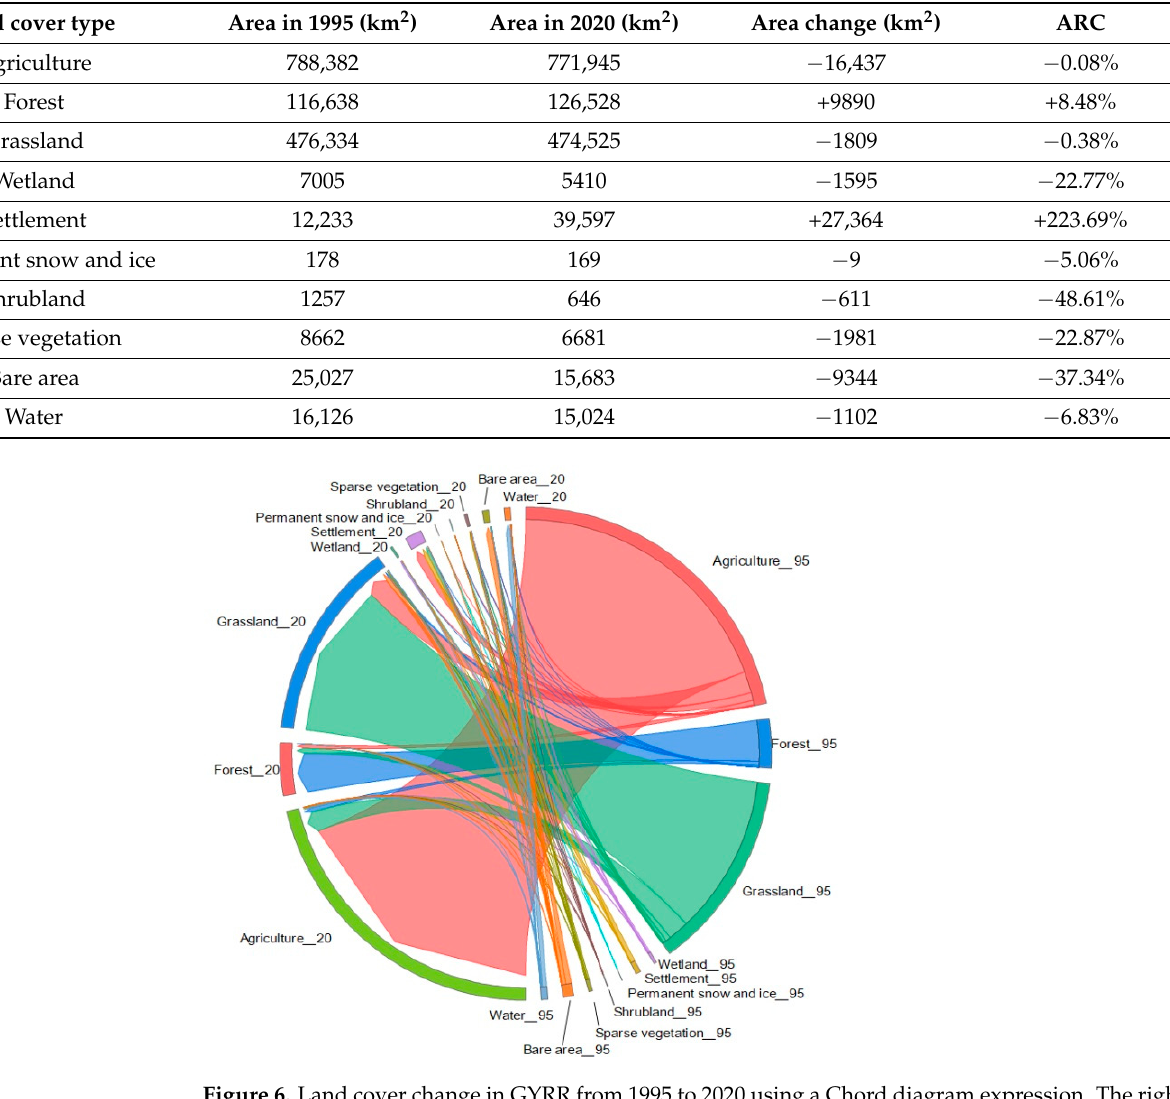
Figure 7. Landscape pattern index analysis. ( a ) SHDI of GYRR; ( b ) SHEI of GYRR. The red line in the figure is a trend line added by the authors. 3.3. Land Cover Prediction in 2020 and Validation We used the MOLUSCE plugin for the simulation of land cover in 2020. Using the projected 2020 data (Figure 8a) for comparison with the actual land cover data in 2020 (Figure 8b), the percentage of correctness was calculated as 96.42%, the Kappa (overall) was 0.94, the Kappa (histo) was 0.98, and the Kappa (loc) was 0.95. The results show that the 10-year interval prediction model has a good result on land cover simulation and prediction.